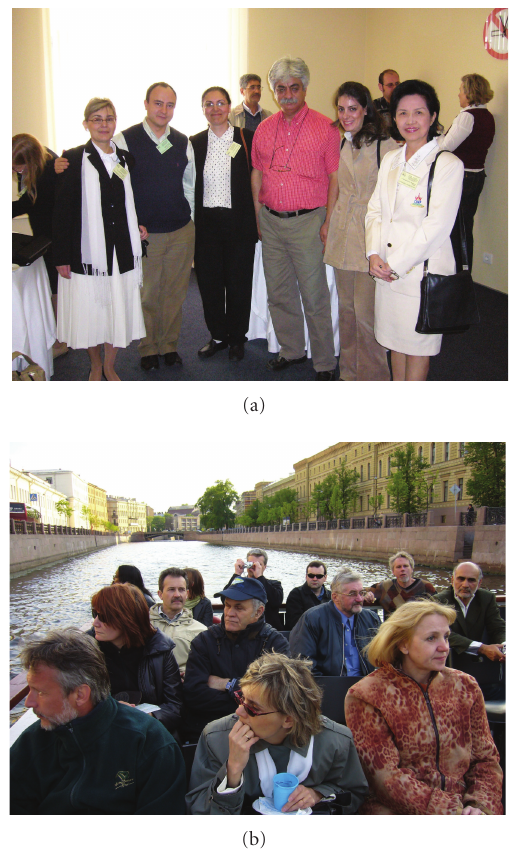
Figure 3: Conference delegates enjoying informal scientific discus- sions and the social program (during boat trip through the canals of St.